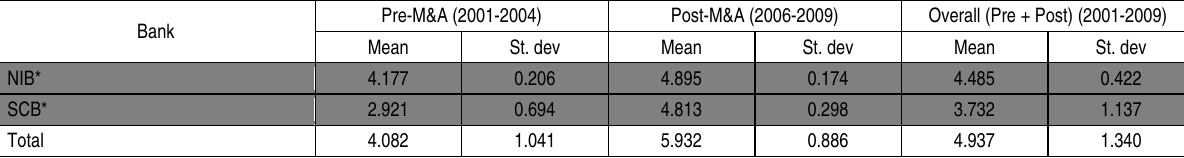
Table 1 (cont.). Descriptive statistics for the 15 banks based on size (ln total assets) and the final number of